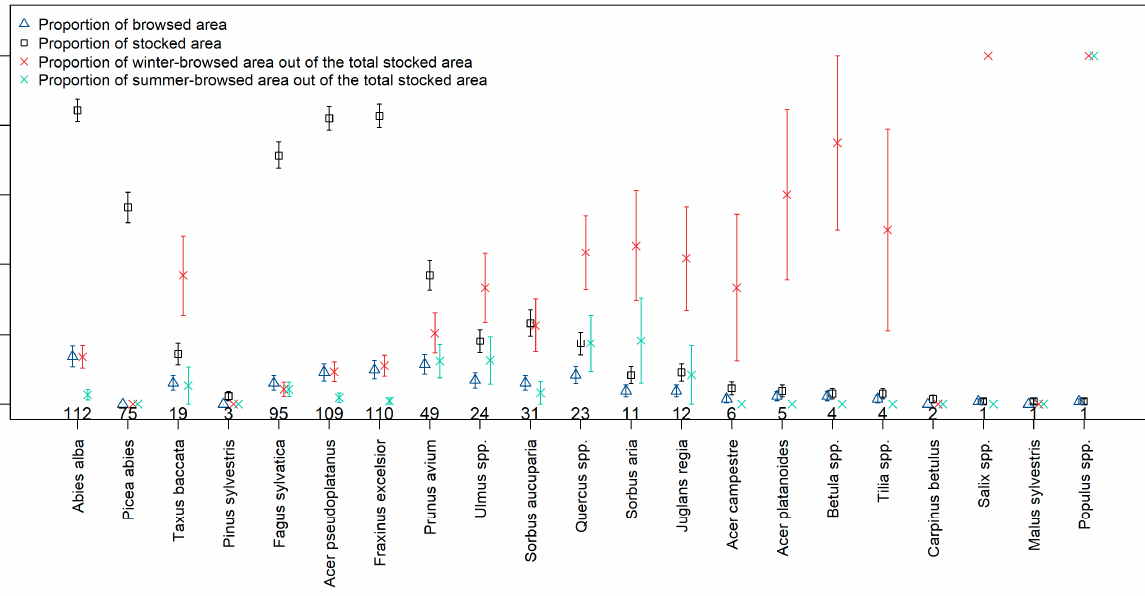
Figure 1. Proportion of occupied area per species. The species are sorted into evergreen and deciduous species and in descending order of total occurrence. The number of plots with saplings of each species is displayed (maximum = 133 assessed plots).